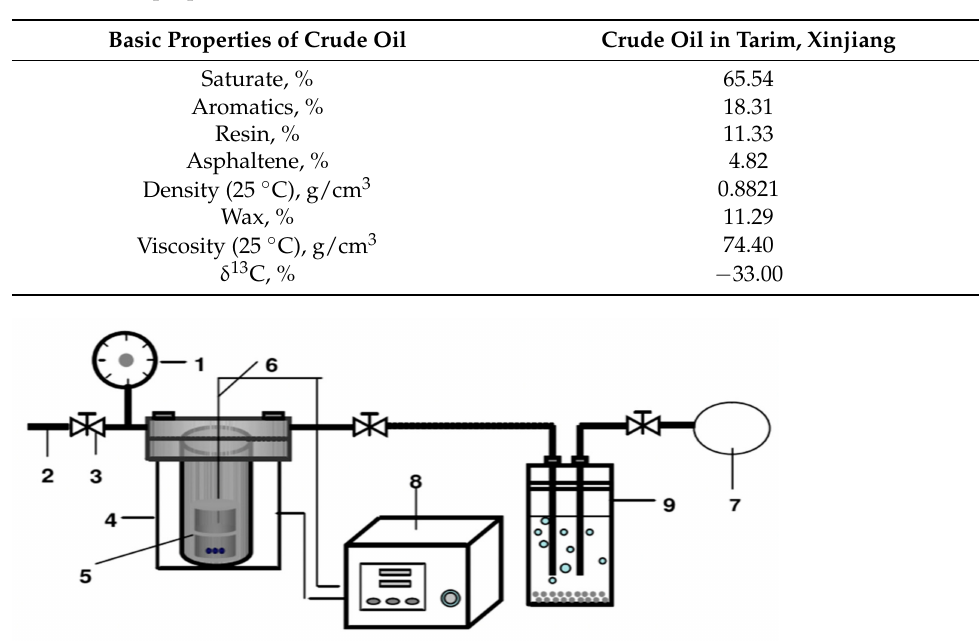
Table 1. Basic properties of crude oil.